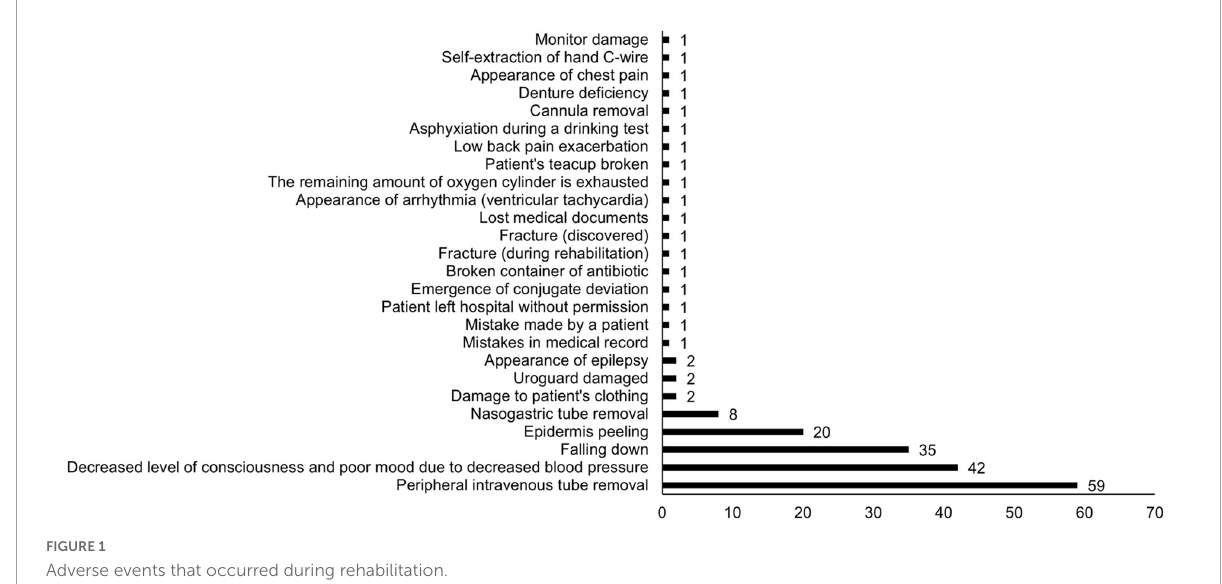
FIGURE1 Adverse events that occurred during